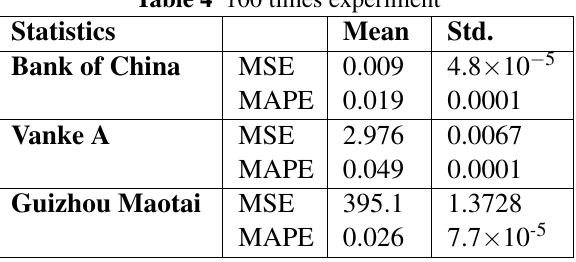
Table 4 100 times